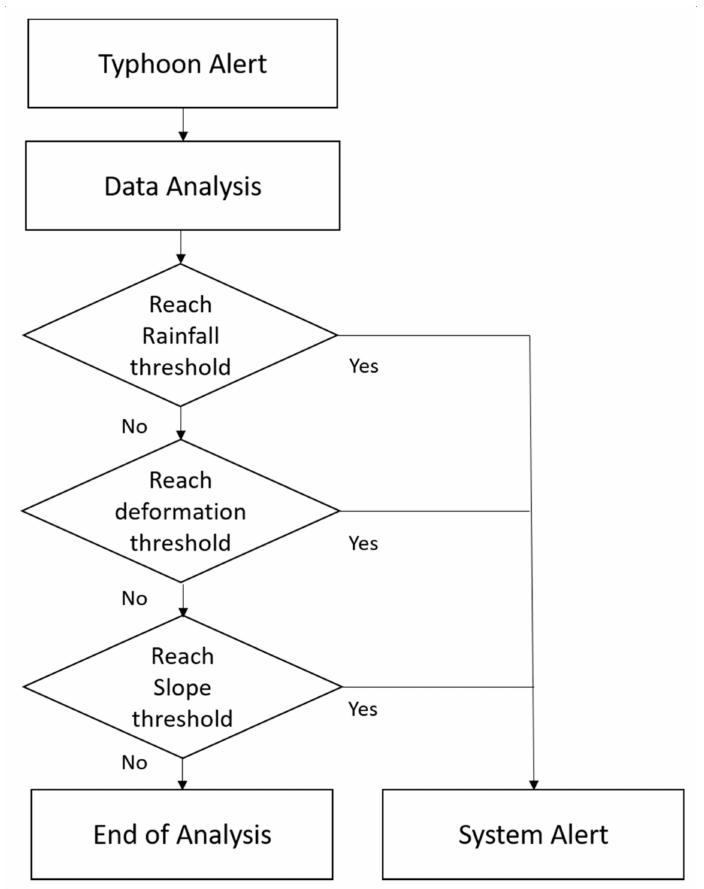
Figure 1. Flowchart of the research